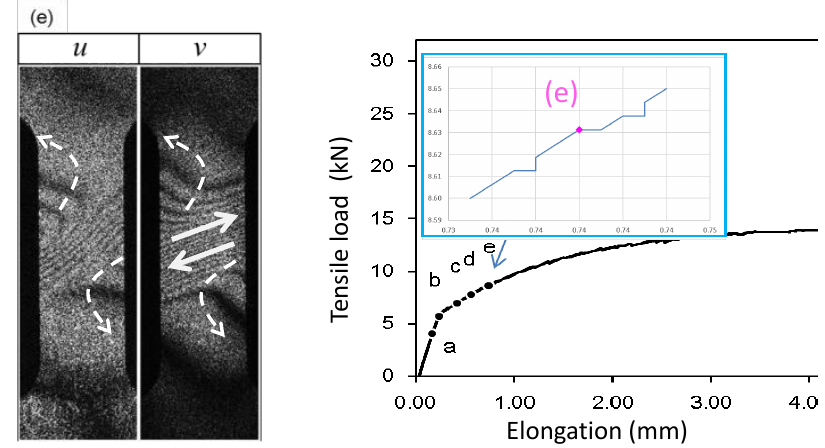
Figure 7. Developed shear stress at Post-Yield 3 stage represented by fringe pattern (e) in Figure 3 and subsequent loading